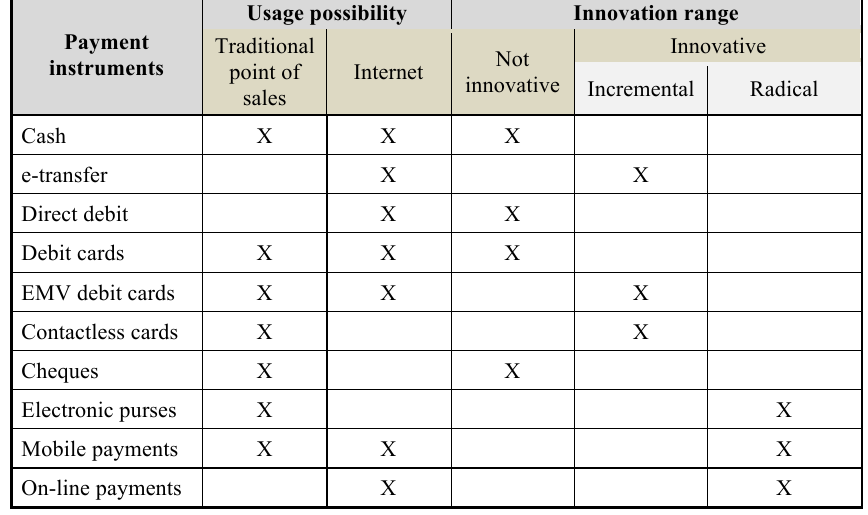
Table 1 Innovation range and usage possibility of selected payment